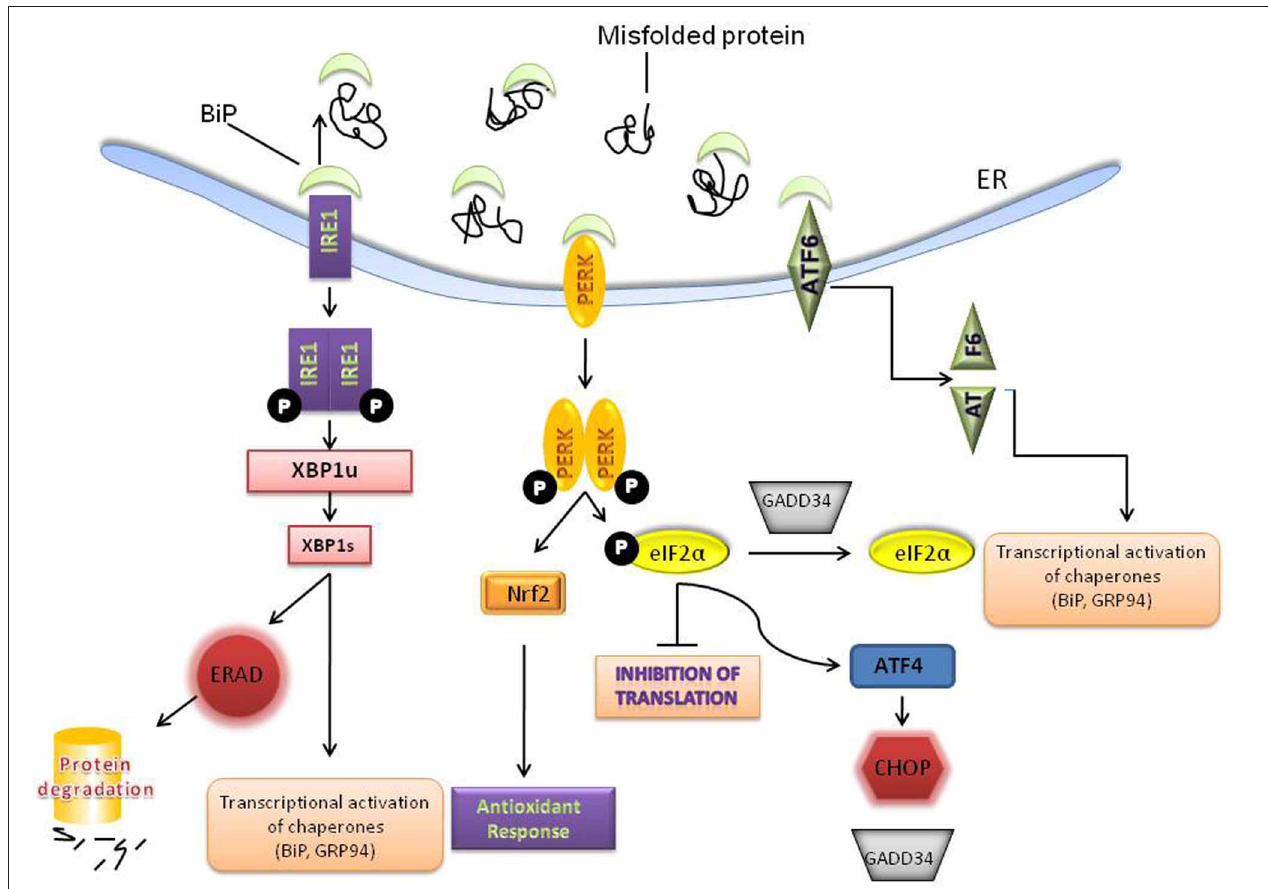
FIGURE 1 | Activation of the unfolded protein response (UPR). Accumulation of misfolded or unfolded proteins in the ER leads to the dissociation of BiP from 3 transducers –PERK, IRE1 and ATF6. PERK homodimerizesand phosphorylates eIF2 α to inhibit general protein translation. PERK also regulates several transcription factors including, NRF-2 to up-regulate the anti-oxidant response and ATF4 which can lead to both protective and apoptotic signaling. IRE-1 activation